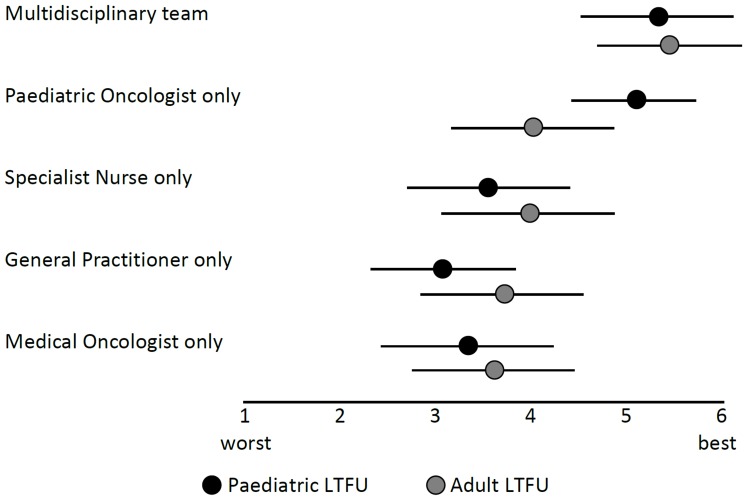
Rating of organizational models of care, by pediatric and adult LTFU.LTFU: long-term follow-up program; dots represent means and lines +/−1 standard deviation; Adapted from Wallace et al. [19].